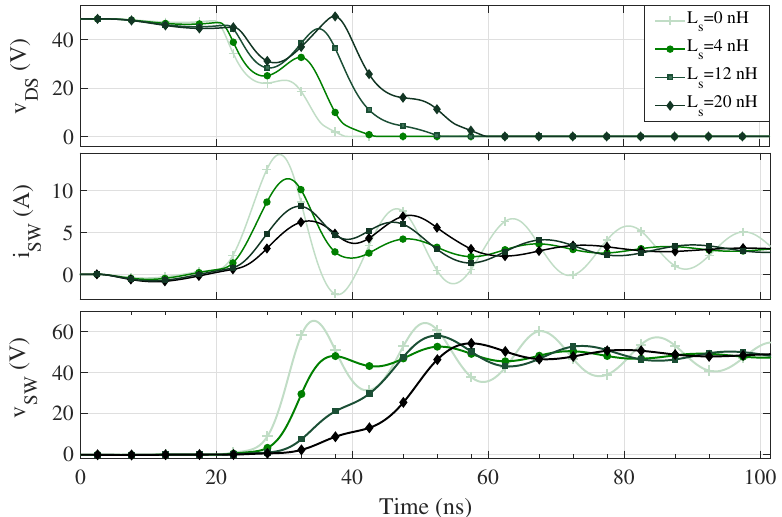
Figure 8. Switching waveforms at the T HS turn-on in the oscillating case (plus markers), and with a 4 nH (circle), 12 nH (square) and 20 nH (diamond markers) L s inductances obtained from a time-domain simulation of the circuit shown in Figure